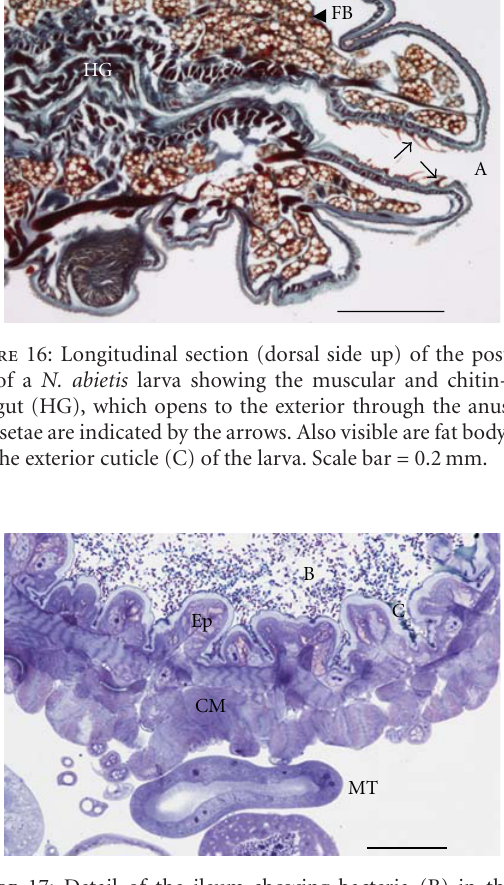
Figure 17: Detail of the ileum showing bacteria (B) in the gut lumen, the thick cuticle (C), single layer of epithelial cells (Ep), and layers of circular muscles(CM). A Malpighiantubule (MT)is visible in the hemocoel. Scale bar = 30 μ